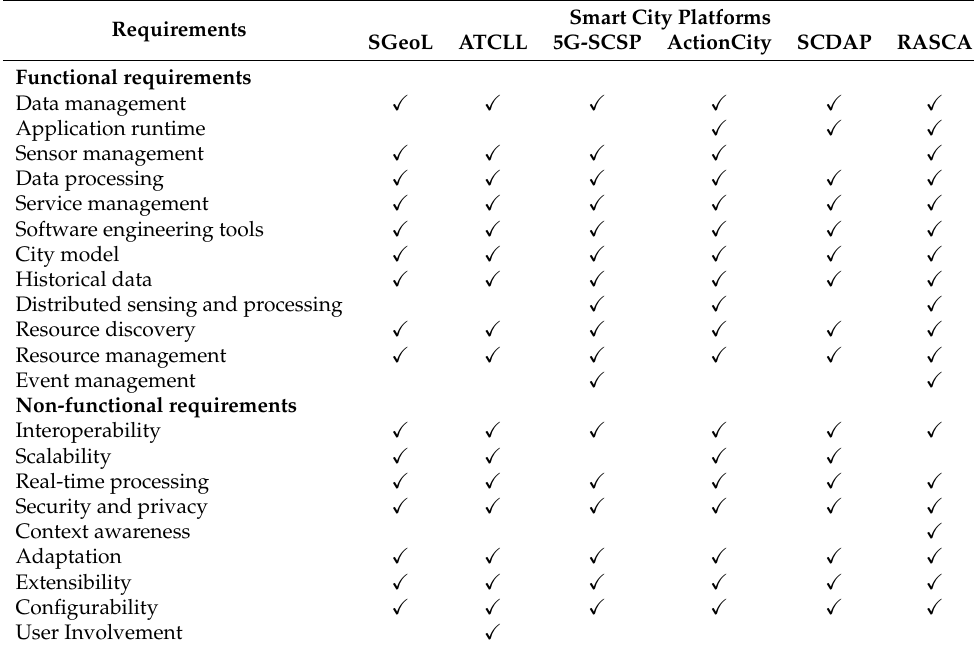
Table 1. Architectural characteristics of some smart city